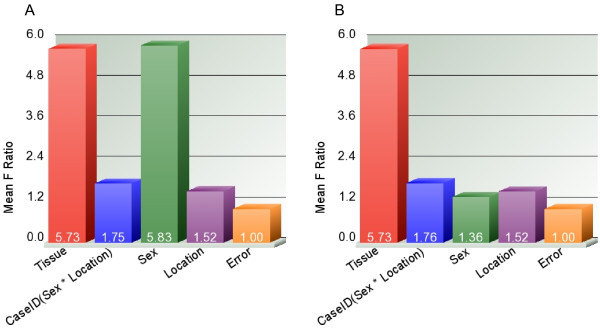
A and B Sources of variation in methylation data. Statistical significance of the different sources of variation in the methylation data estimated by 4-way ANOVA models. F-ratio for each factor (source) represents the F-statistics for that factor/F-statistics for error (noise). 1A shows the result in all 27,578 loci and 1B shows similar result only in the autosomal loci (n = 26,486) depicting the effect of sex chromosomal markers.